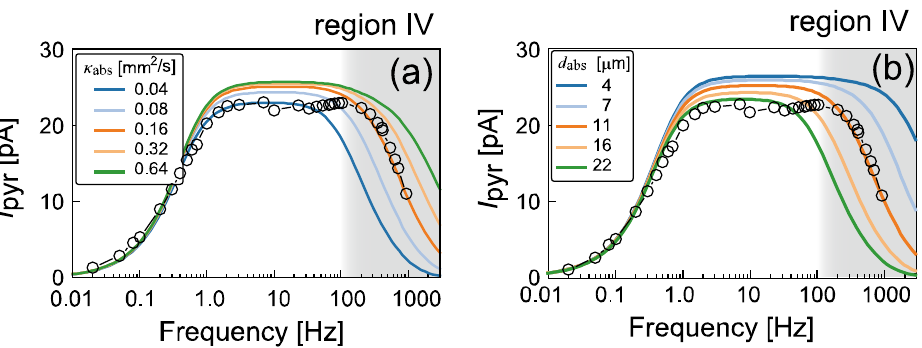
Figure 6. Comparisons between the observed pyroelectricity of LiNbO 3 and the results of the two- layer model calculation plotted as a function of the temperature-modulation frequency. Panels ( a ) and ( b ) show the dependence on κ abs and d abs , respectively. In the calculations, c abs and ρ abs are supposed as 1.4 J/gK and 0.76 g/cm 3 , respectively. In (b), 𝜅 abs is assumed as 0.16 mm 2 /s .